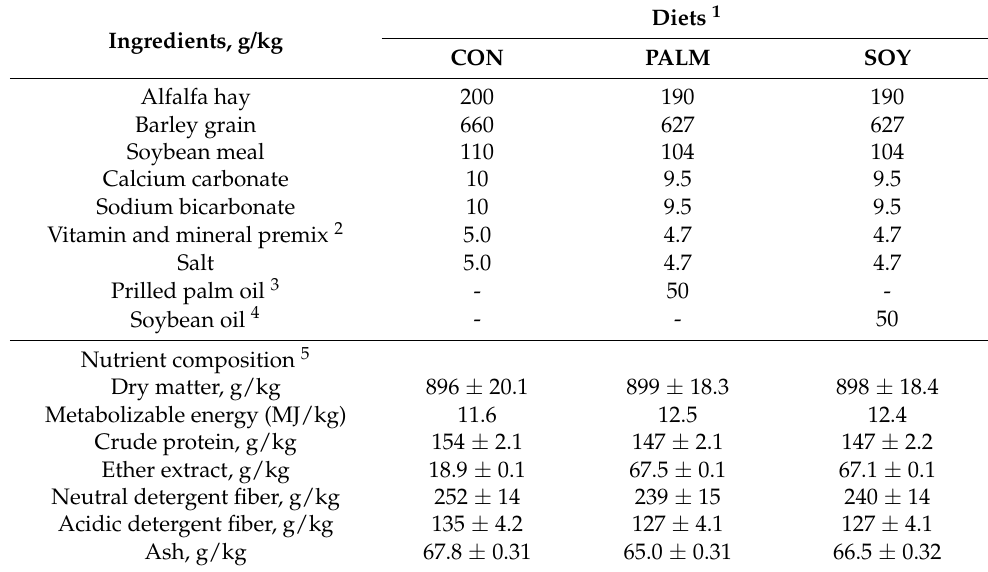
Table 1. Feed ingredients and chemical composition of experimental diets with prilled palm oil (PALM) or soybean oil (SOY) or without fat supplements (CON). Diets 1 Ingredients, g/kg CON PALM SOY Alfalfa hay 200 190 Barley grain 660 Soybean